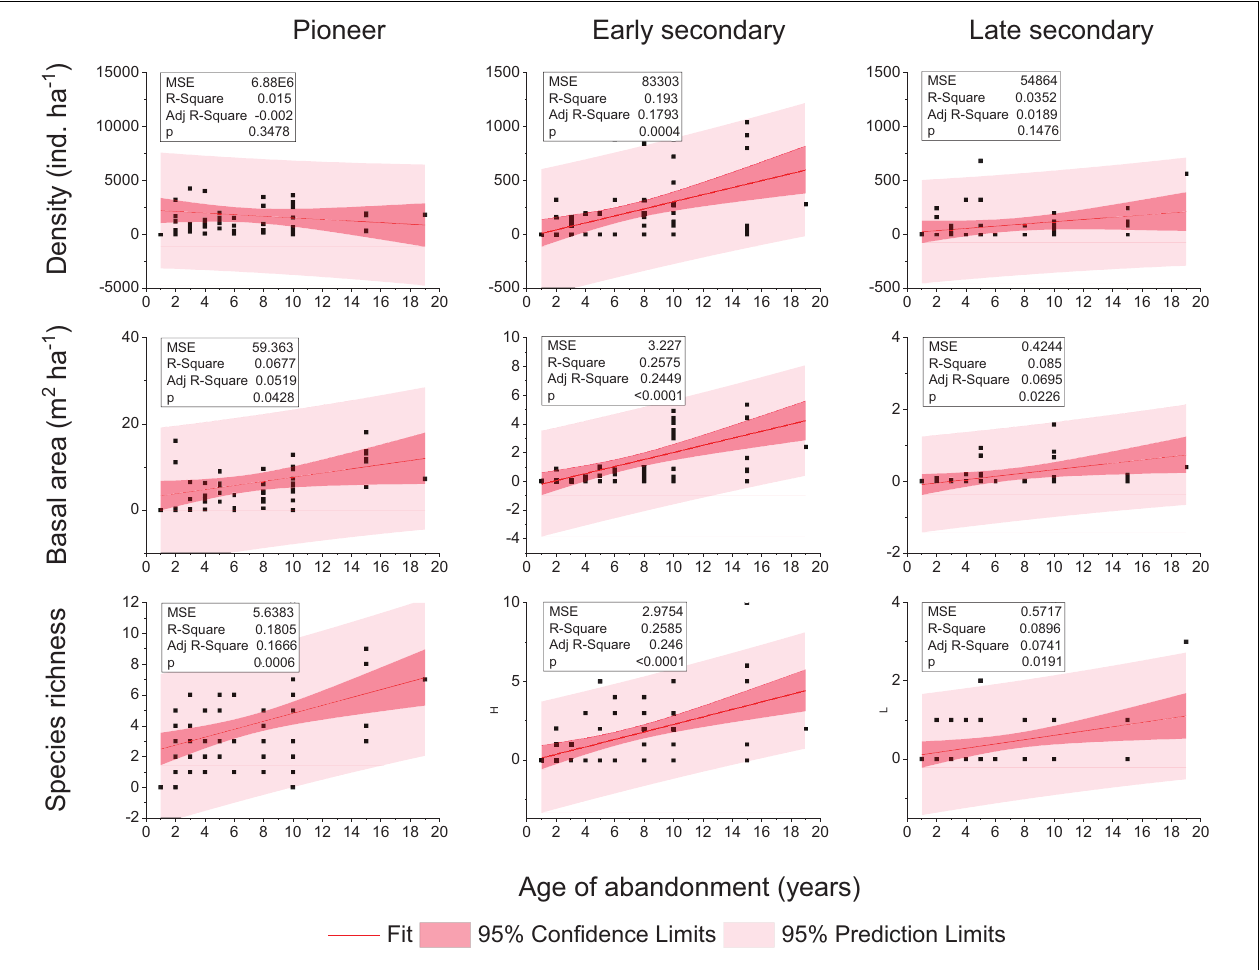
FIGURE 2 | Relationships observed between the age of abandoned mining plots and density, basal area, and species richness for each successional status. Data correspond to 61 plot observations including pioneer, early secondary, and late secondary species. Linear regressions and correlation statistics are also shown.